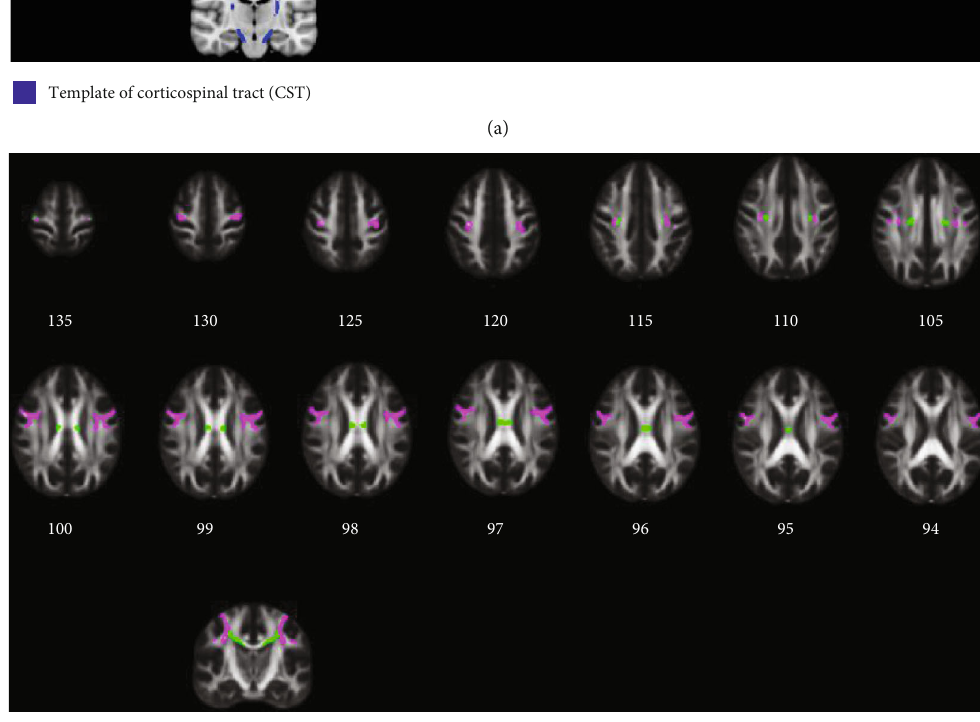
Figure 1: Template tract. Three template tracts were conducted by probabilistic tractography in 26 healthy subjects. The longitudinal tracts are shown in (a); the blue template is the corticospinal tract. The corticocortical connections are shown in (b); the pink template is intrahemispheric corticocortical connections from the primary motor cortex to the ventral premotor cortex, and the green template is interhemispheric corticocortical connections from both primary motor